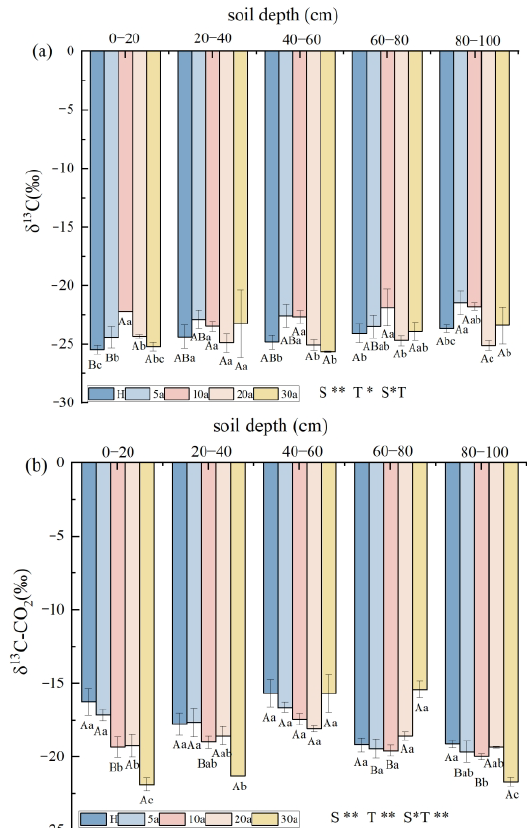
Figure 3. Profile distribution characteristics of stable carbon isotope characteristic values ( δ 13 C) of SIC ( a ) and CO 2 ( b ) in cotton field soils with different continuous cropping years. Note: Different capital letters indicate significant differences between different soil depths in the same succession year, and different lowercase letters indicate significant differences between different continuous cropping years at the same soil depth; S indicates the main effect of different continuous cropping years, T indicates the main effect of different soil layers, and S*T indicates the interaction effect of different continuous cropping years and different soil layers; ** indicates a highly significant correlation ( p < 0.01), and * indicates a significant correlation ( p < 0.05).